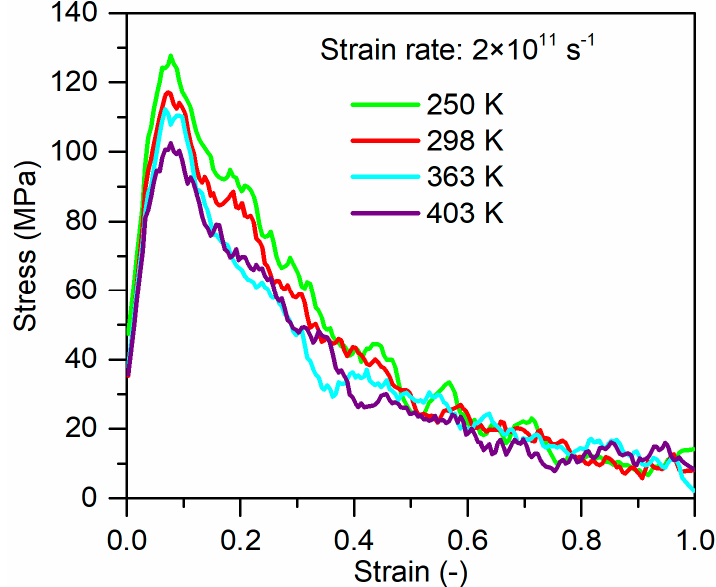
Figure 4. Tensile stress-strain curves of glass fiber/PP composites at different loading temperatures.